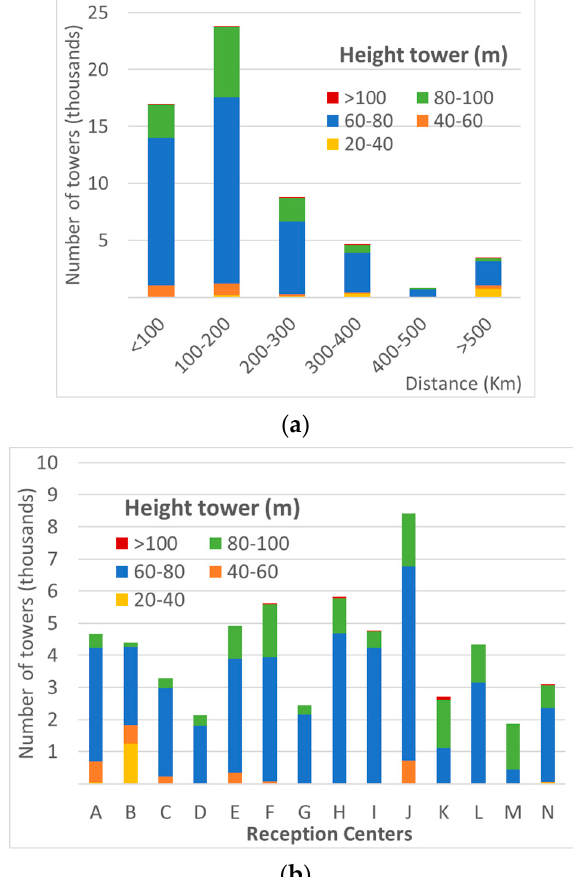
Figure 15. Analysis of turbine towers with corresponding US—EoL center: ( a ) transportation distance (km), ( b ) required capacity according to tower height.